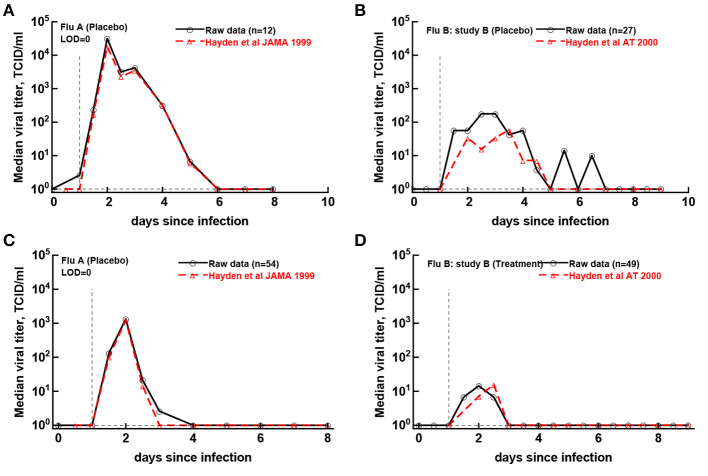
Previously published median virus shedding data could be reproduced for one but not another clinical trial. We compared median shedding data published previously for clinical trial with flu A (Hayden et al., 1999) or flu B study B (Hayden et al., 2000) with median shedding calculated from the raw trial data. The best match was found by assuming LOD = 0. For every panel we also list the number of volunteers used to calculate the median titers. The best match was obtained by shifting the published median shedding curves by 12 h (A,C) or by 24 h (B,D).